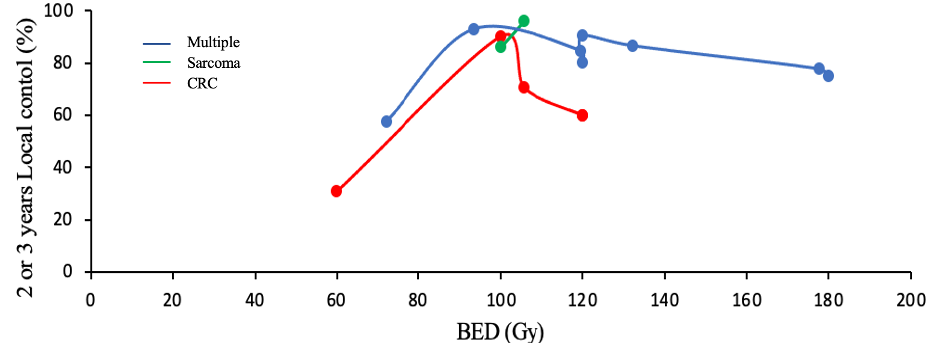
Figure 2. Local control depending on biologically effective dose according to the primitive cancer (considering α/β = 10 Gy).